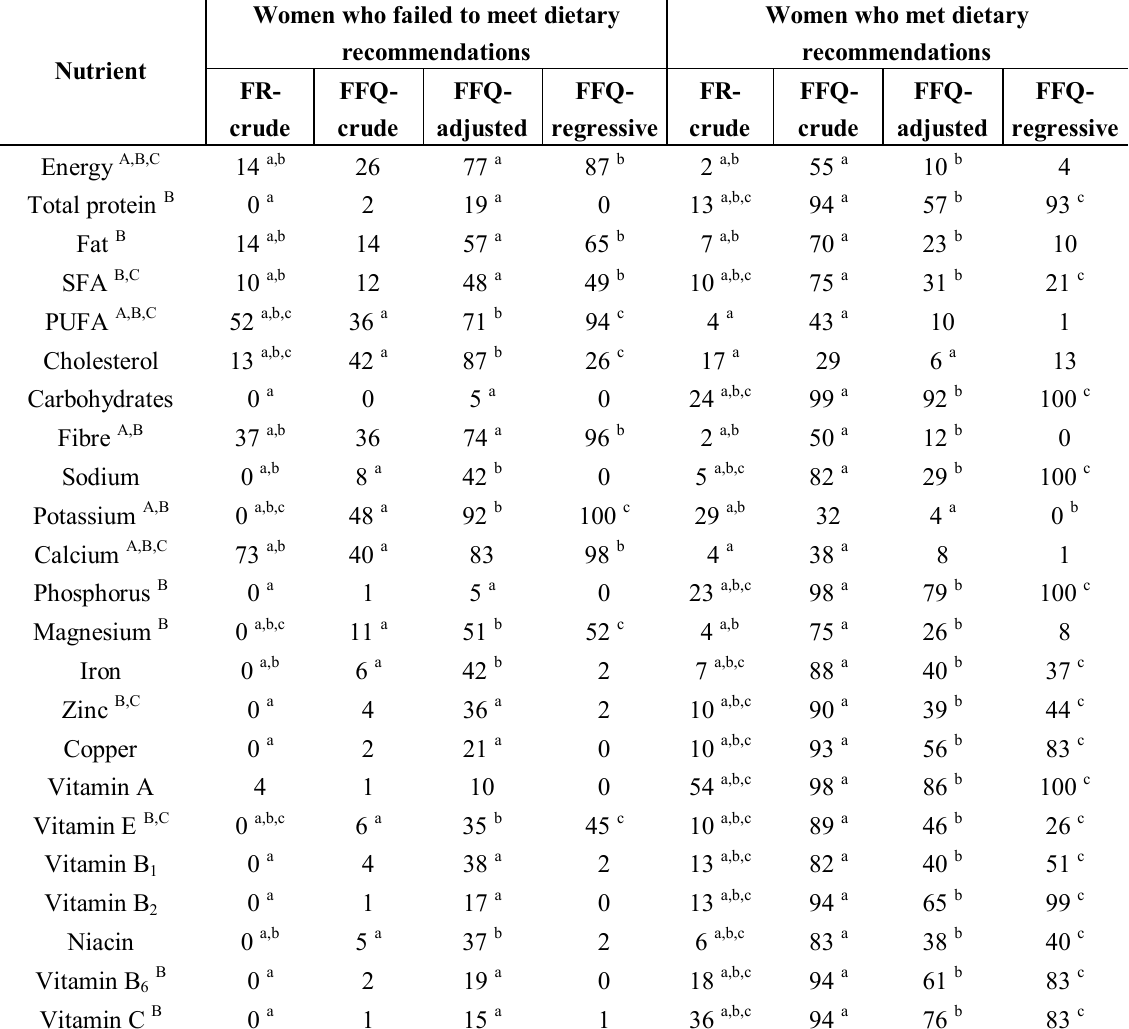
Table 4. Comparison of the distribution of the percentage of women who failed to meet or met Polish dietary recommendations for energy and nutrients ( n 84, % of the